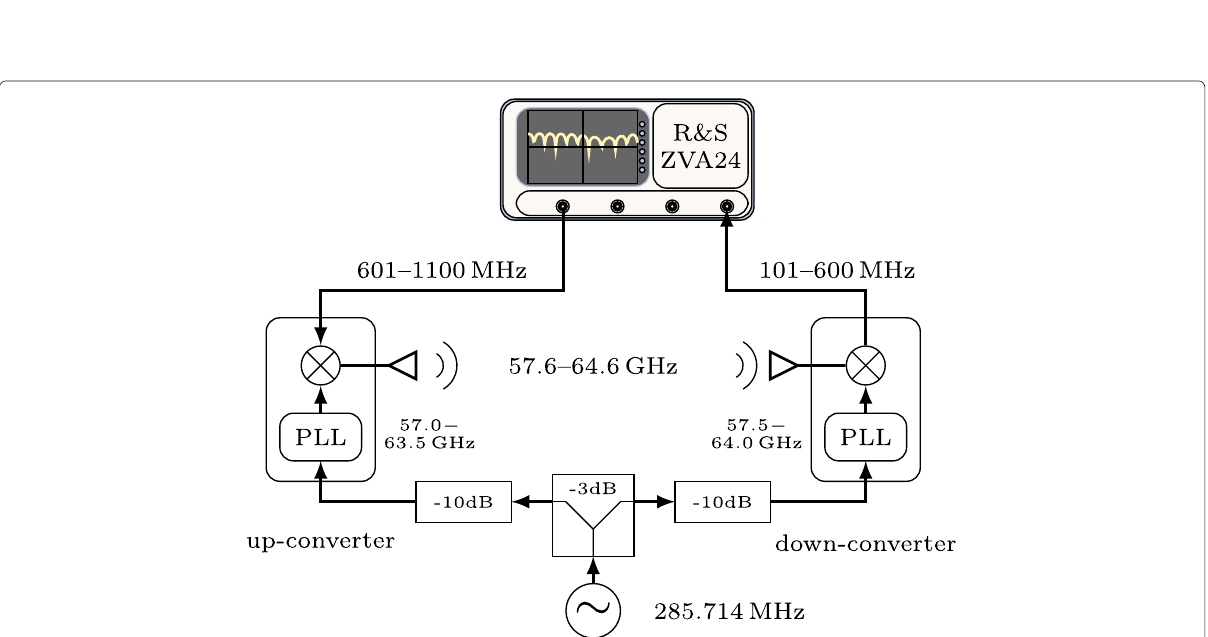
Fig. 6 RF set-up for MC1. The combination of different PLL scaling factors allows for a measurement bandwidth of 7GHz. The reference clock for the up-converter and the down-converter is shared. The power splitter has an isolation of 30dB. To avoid possible leakage on the clock distribution network, attenuators additionally decouple both converters. The transfer function is measured applying the conversion gain (mixer) measurement option of the R&S